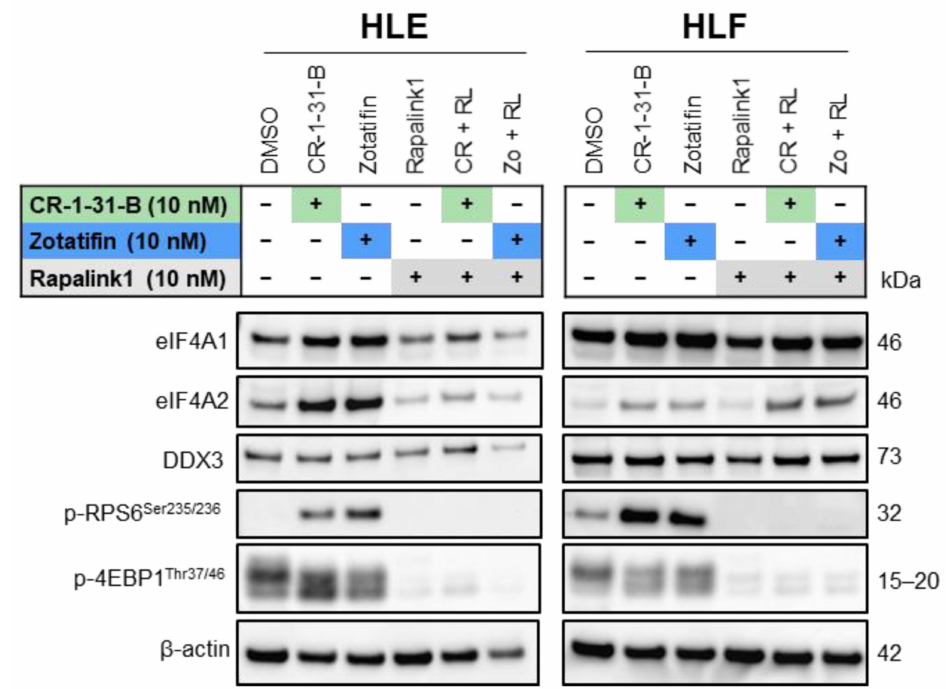
Figure 12. Complete inactivation of mTOR effectors after synergistic eIF4A and mTOR inhibition using CR-1-31-B and Zotatifin in combination with Rapalink-1 in HCC cell lines. Western blot analysis in HLE and HLF cell lines challenged with CR-1-31-B (10 nM) and Zotatifin (10 nM) and Rapalink-1 (10 nM) inhibitors, alone or in combination (1:1). Cells were treated for 48 h, and western blot analysis was conducted at this time